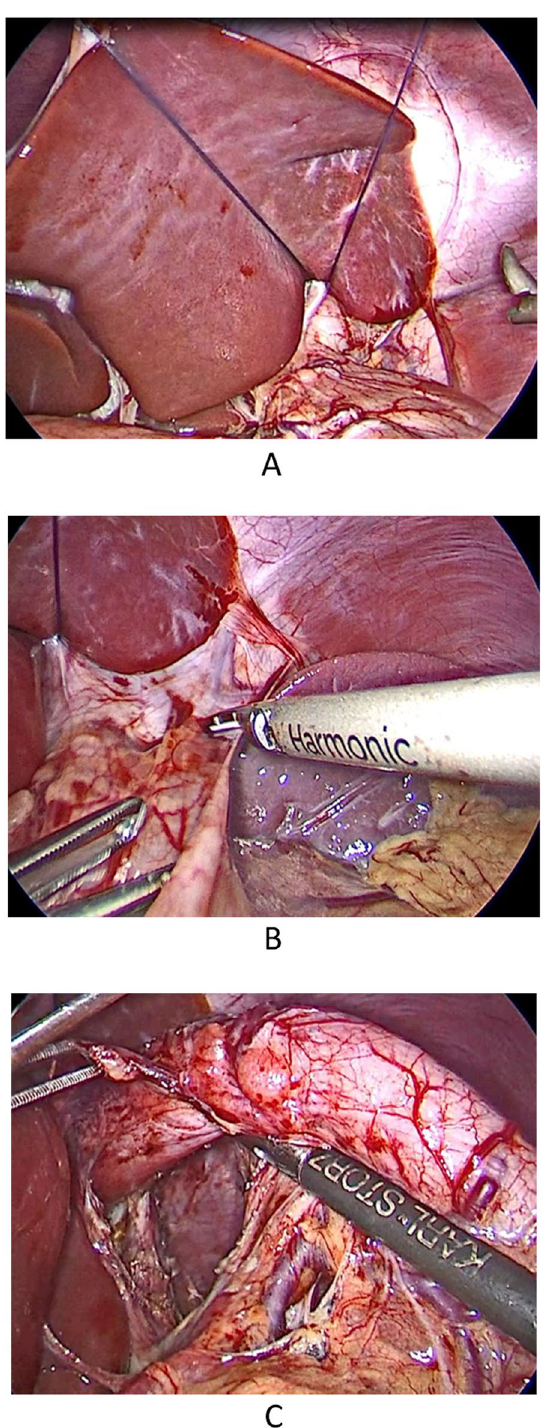
Fig. 1 A Retraction of the liver with a suture passing from abdominal wall to the diaphragm. B Dissection starting at the gastrophrenic ligament. C Completed esophageal and crural